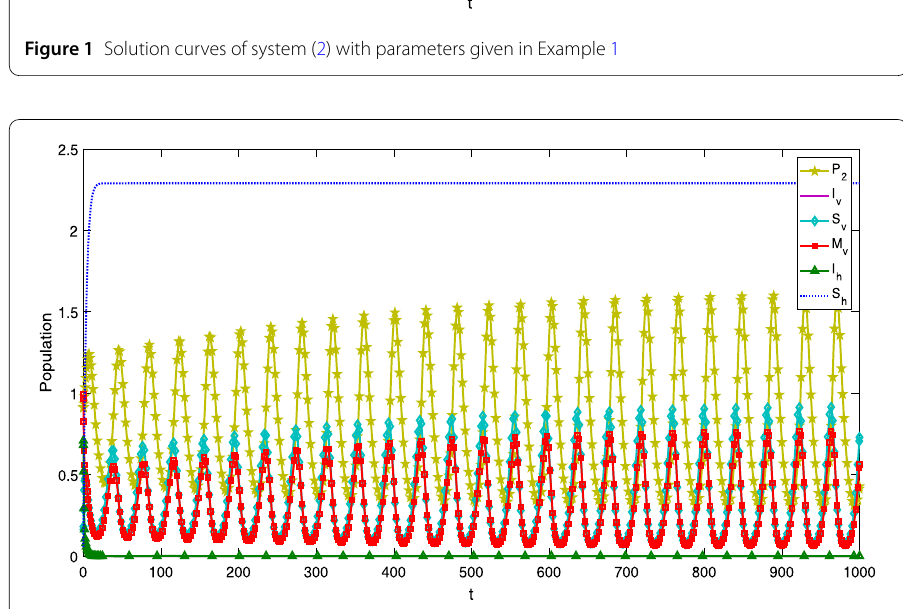
Figure 2 Solution curves of system (1) with parameters given in Example